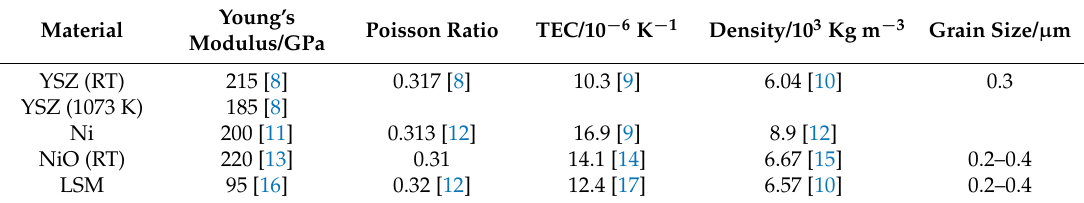
Table 1. Mechanical properties of dense materials (RT = room